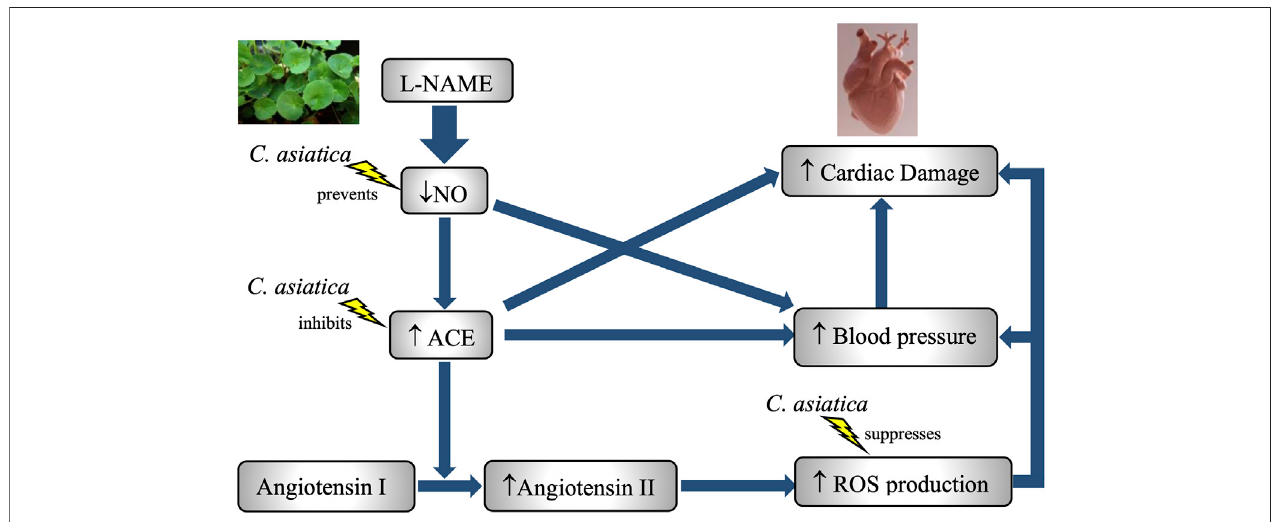
FIGURE 7 | A schematic diagram on the role of NO de fi ciency in L -NAME-induced hypertension and cardiotoxicity in rats. Treatment with C. asiatica extract exhibitedanti-hypertensiveandcardioprotectiveeffectsviatheenhancementofNObioavailability,thesuppressionofRAASandameliorationofoxidativestressstatusin L -NAME-treated group.